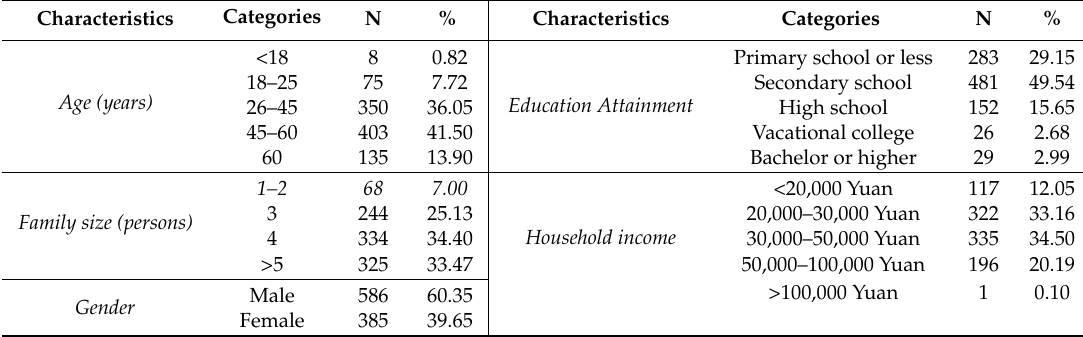
Table 1. Description of the